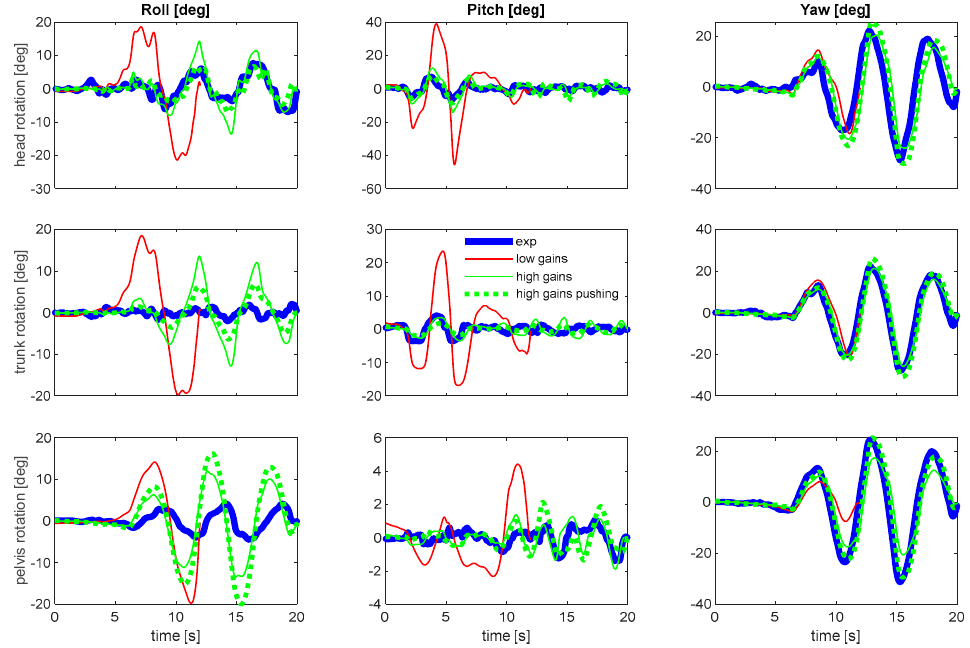
Figure 2. Slalom validation for body rotation . Model prediction of head ( upper ), trunk ( middle ) and pelvis ( lower ) orientations. Blue line: experimental; dotted green line: best model fit with high postural gains and with hips and knees pushing the body into the seat back; solid green line: high gains but no pushing; red line: lower postural gains fitted towards the vibration